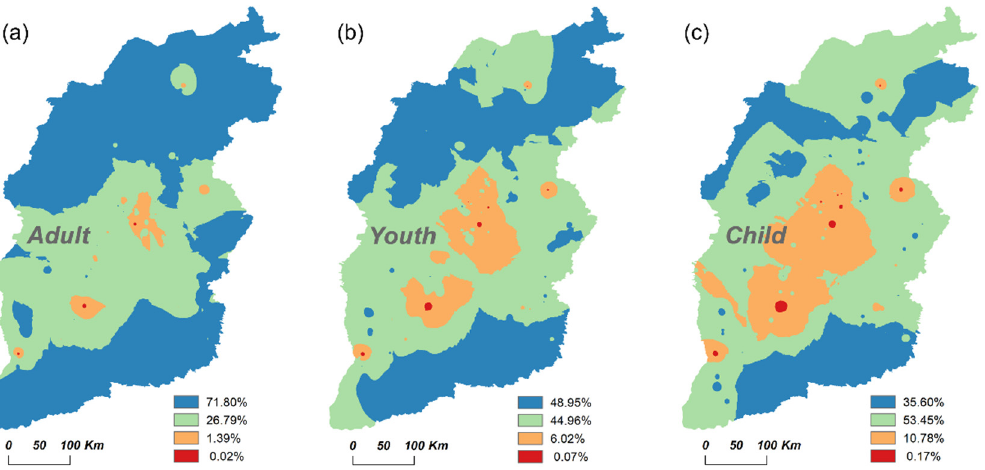
Figure 8. Spatial patterns and composition proportion of risk level of children ( a ), youths ( b ), and adults ( c ) in soil PAHs.